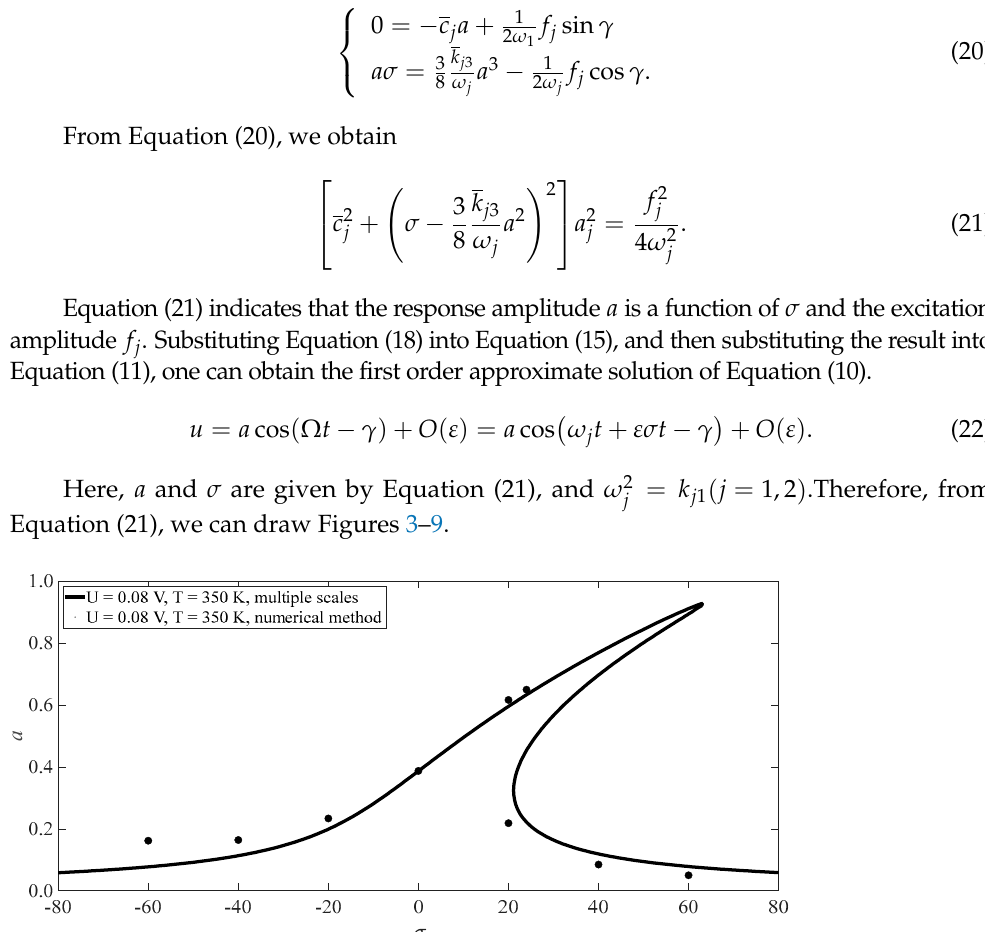
Figure 3. Frequency − response curves of the first mode with ( c 1 , f 1 ) = ( 5,4.95 ) .